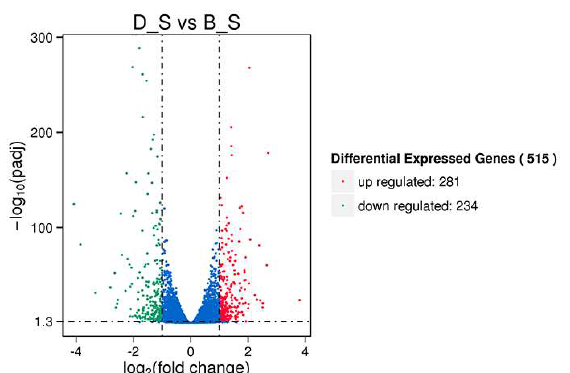
Figure 2. The volcano map depicts differentially expressed genes between the two groups of spleens. Significant differential expression genes (SDEGs) are shown as blue (down) and red (up) dots, and gray dots show a lack of significance.